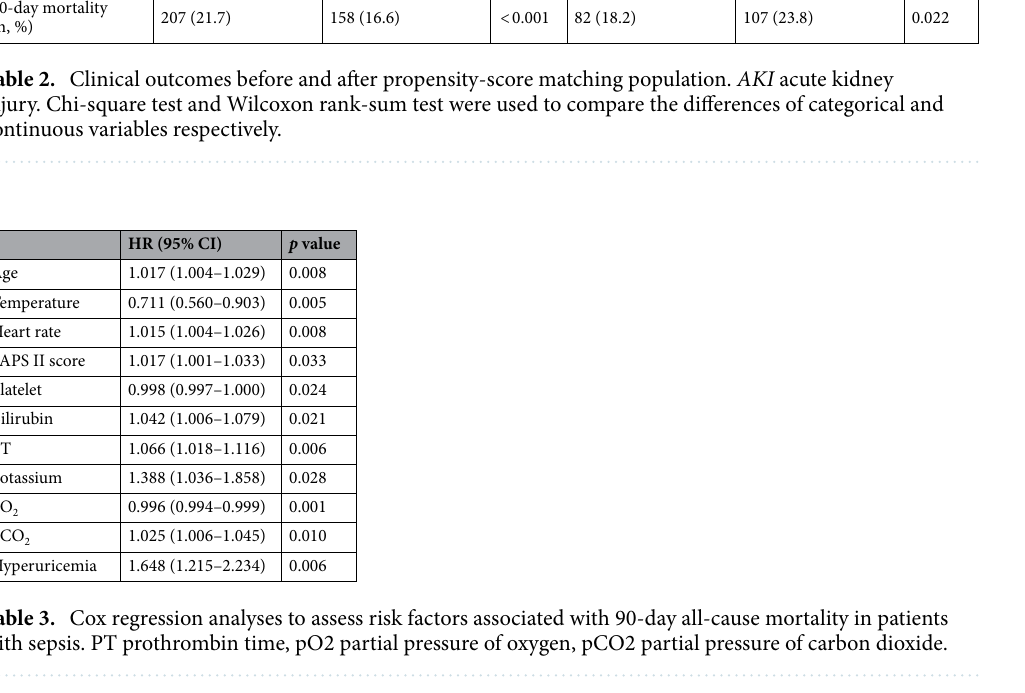
OR (95% CI) p value Length of